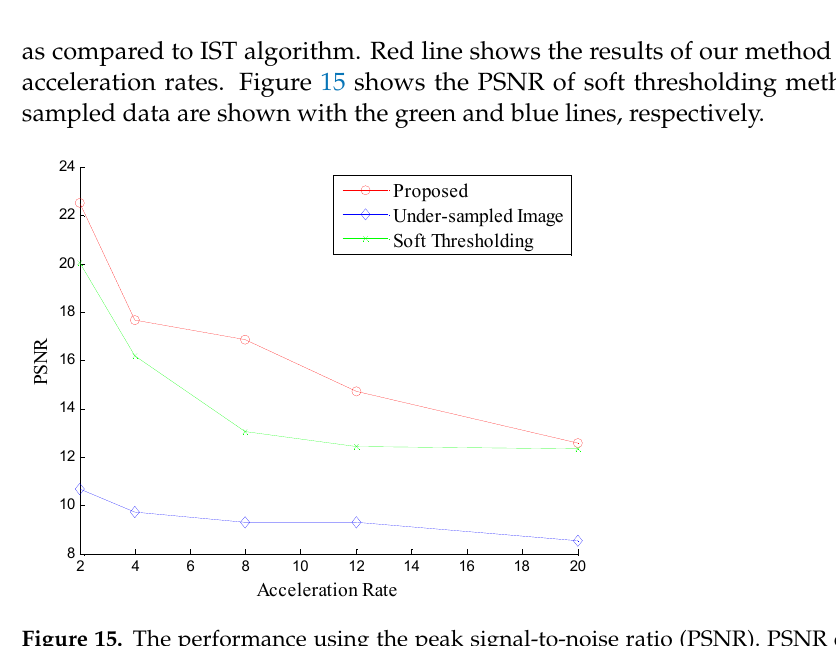
Table 5. Comparison of proposed method with conventional IST algorithm with RMSE. Proposed method performance is much better as acceleration rates are